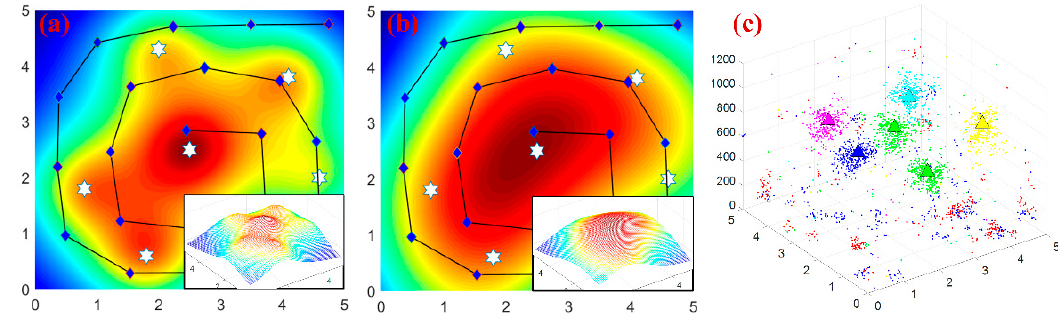
Figure 8. The simulation scenario for 6 radiation sources localization. ( a ) Theoretical radiation strength distribution. ( b ) Radiation strength distribution with simply GPs regression. ( c ) The estimation results of the multiple-layer PSPF algorithm.